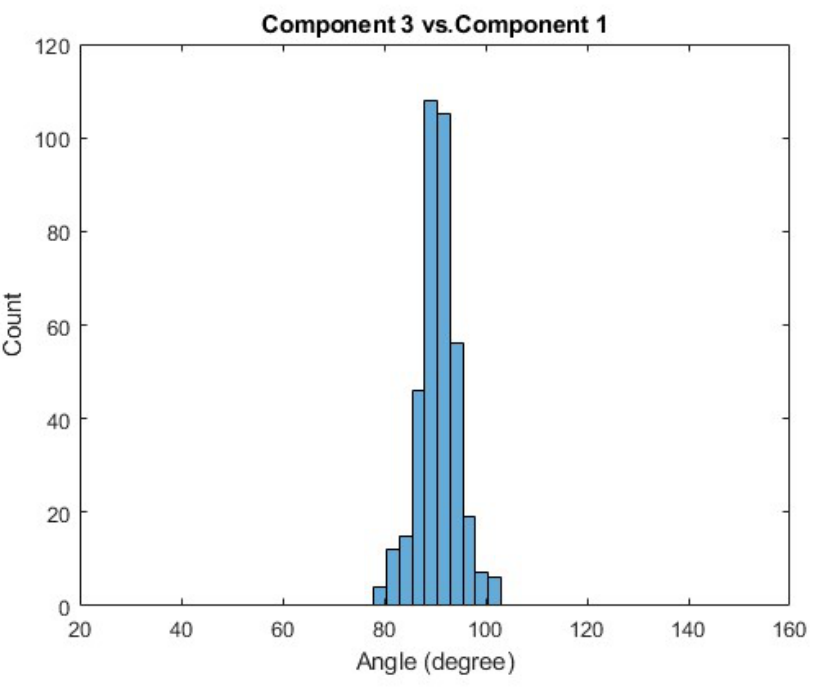
Figure A7. Histogram of the comparisons between the third principal component of some Trial A and the first principal components of some Trial B, where these comparisons are made across all trials and